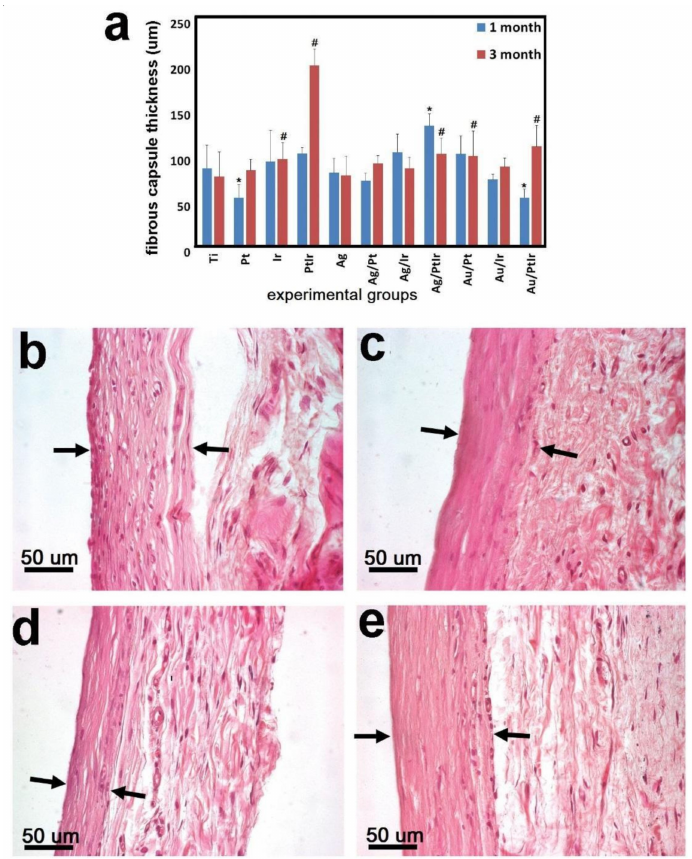
Figure 11. The thickness of the fibrous capsule around experimental samples after 1 and 3 months of subcutaneous implantation in rats ( a ); # significant differences with the control group (1 month), * significant differences with the control group (3 months). Dynamics of the formation of a fibrous capsule (black arrows—capsule border) around series of experimental samples with AgNPs: Au/Pt 1 month ( b ), Au/Pt 3 months ( c ), Au/PtIr 1 month ( d ), and Au/PtIr 3 months ( e